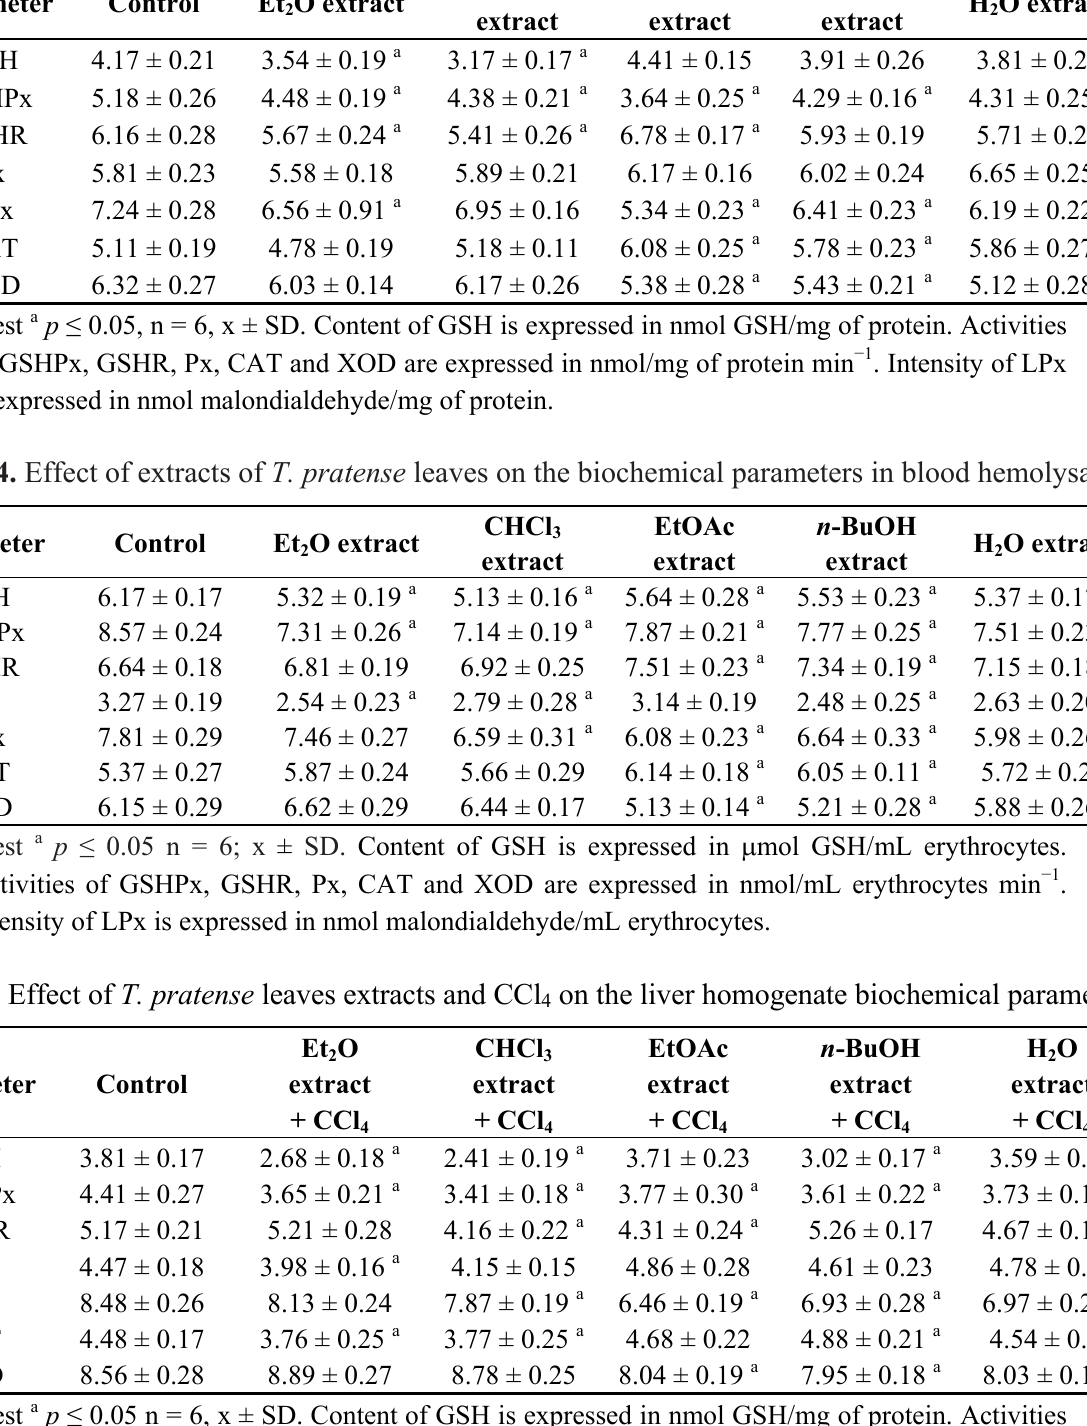
Table 3. Effect of extracts of T. pratense leaves on the biochemical parameters in the liver homogenate. Parameter